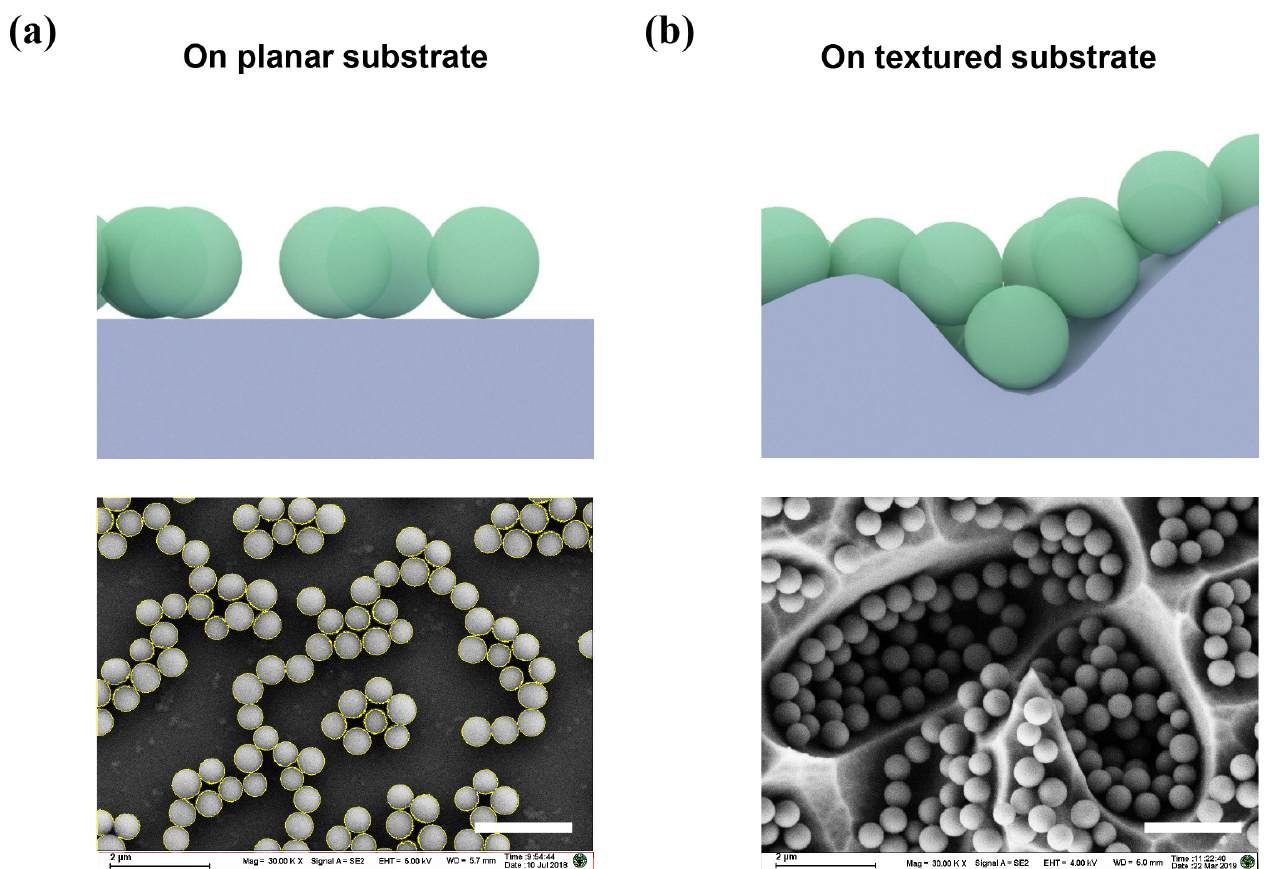
Figure 2. Schematic illustration and SEM graphs of self-assembled SiO 2 nanocoating on the planar and textured substrates: ( a ) Assembly on a planar substrate, schematic representation ( top ), and the SEM graphs ( down ). The yellow circles around nanospheres were used to calculate the surface coverage of nanospheres with the ImageJ software; ( b ) Assembly on a textured substrate, schematic representation ( top ), and the SEM graphs ( down ). The dipping time in SiO 2 assembly solution is the same (10 min) for the planar and textured substrate. The scale bar is 2 μ m.